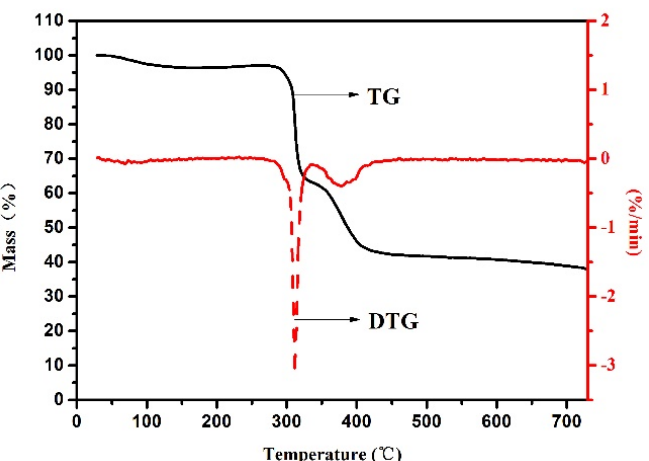
Figure 4. TG analysis of copolymer under nitrogen atmosphere.